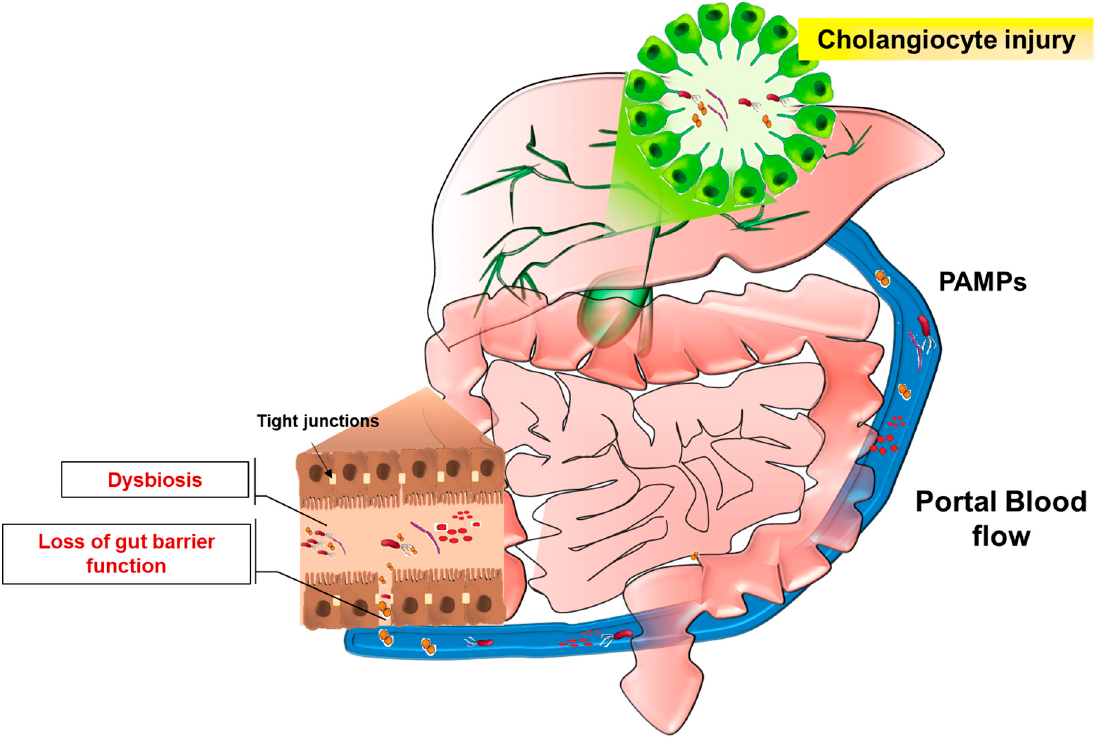
Figure 2. The leaky-gut hypothesis. Portal blood flow ensures the metabolic connection between intestine and liver. During gut inflammation, which leads to impairment of intestinal barrier functions (e.g., downregulation of tight junctions), or as a consequence of dysbiosis establishment, a considerable amount of microorganisms and related molecules (PAMPs) reach the liver and may determine hepatobiliary inflammation. In this context, deregulation of cholangiocyte response to injury is thought to contribute to disease onset and progression.